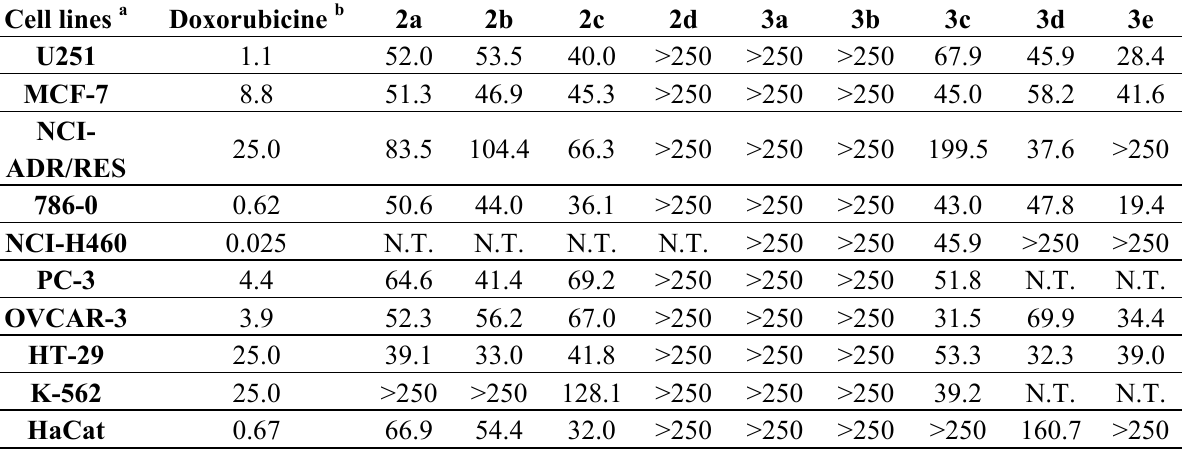
Table 4. Total growth inhibition (TGI, μ g/mL) of 2a – d and 3a – e on human cell